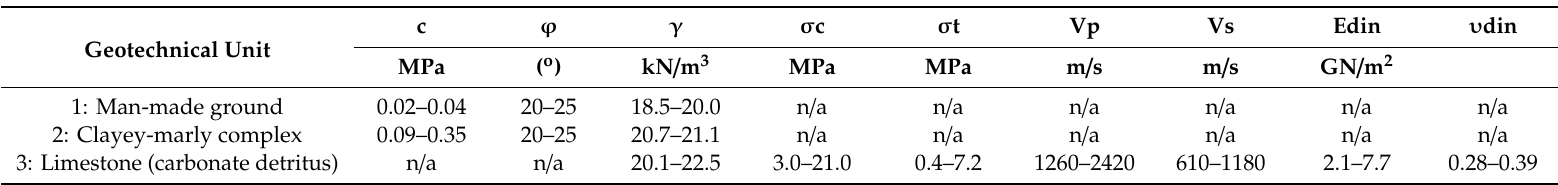
Table 1. Material parameters of geotechnical units derived from the laboratory and in-situ testing (c—Apparent cohesion, ϕ —Angle of shear resistance, γ —Unit weight, σ c—Uniaxial compression strength, σ t—Tension strength, Vp—Velocity of compressive waves, vs.—Velocity of shear waves, Edin—Elastic modulus from dynamic measurements, υ din—Poisson coe ffi cient from dynamic